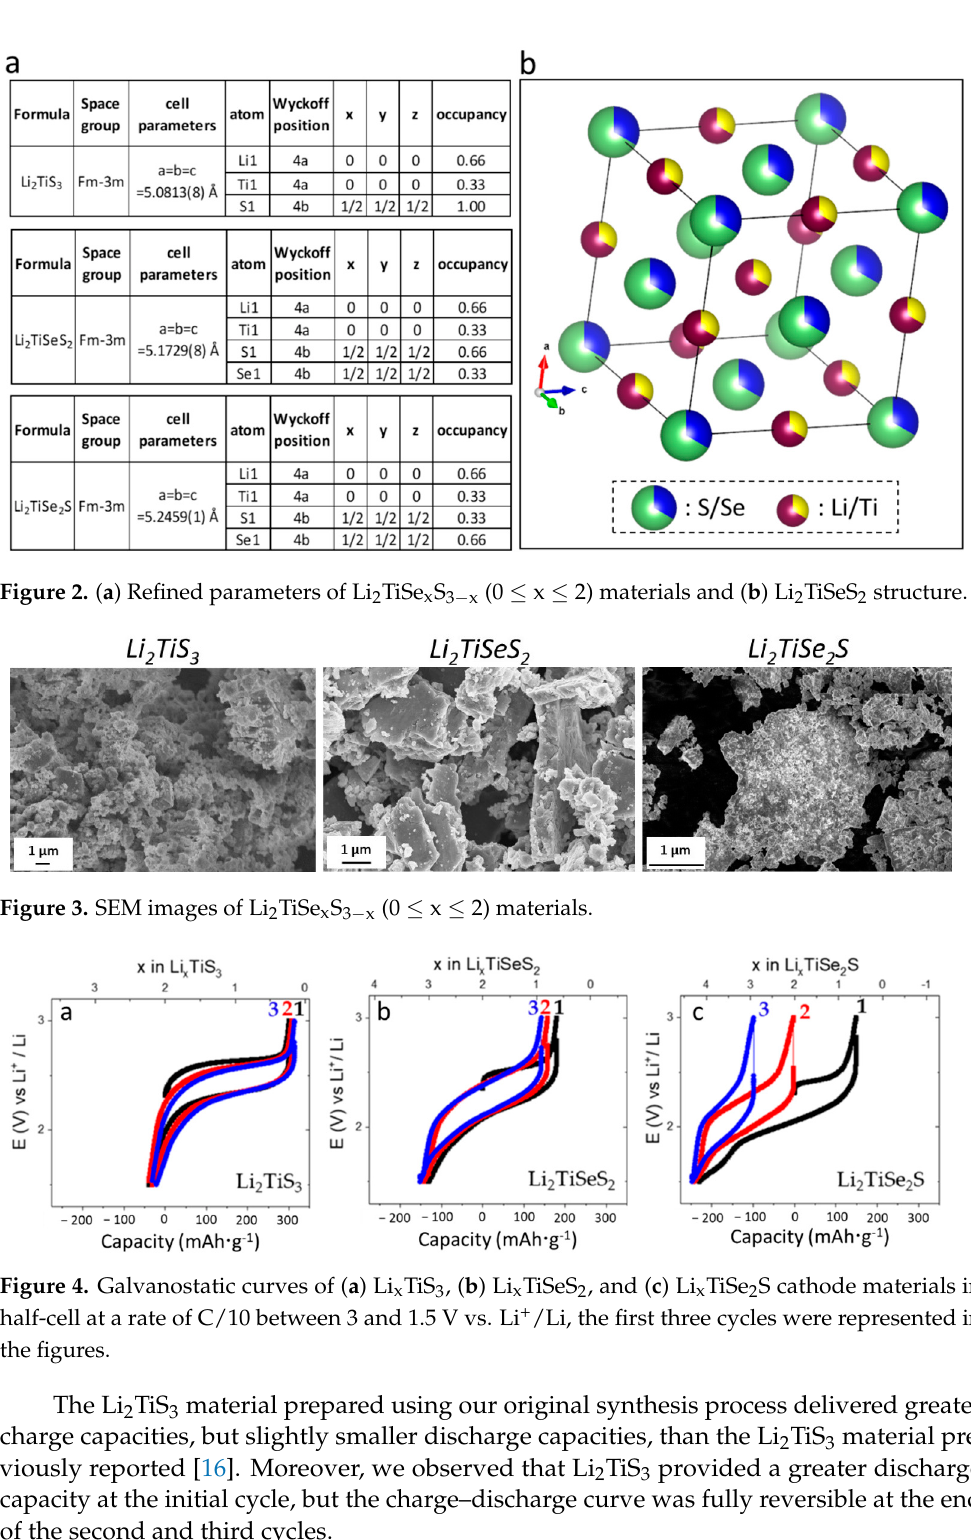
Table 1. Summary of electrochemical performances of Li 2 TiSe x S 3 − x (0 ≤ x ≤ 2) materials.